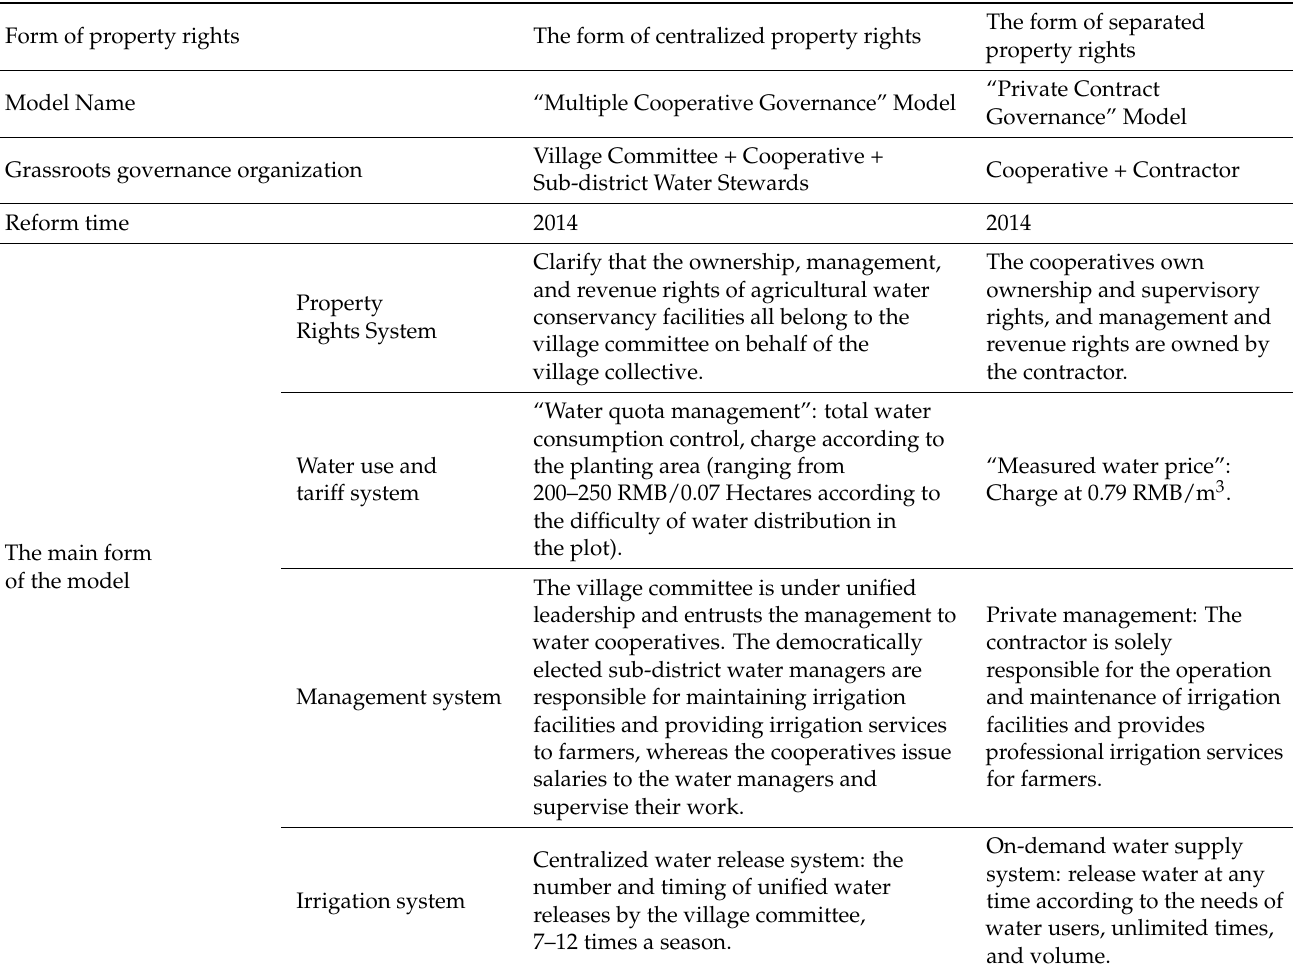
Table 1. Brief description of two models of reform pilot in Lu Liang County, Yunnan,